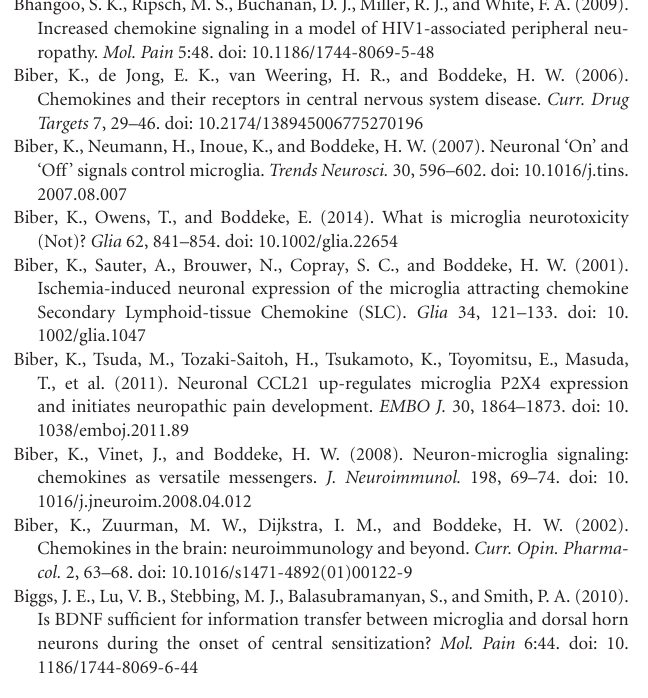
FIGURE 1 | The different roles of CCL2 and CCL21 in the development of neuropathic pain . Both chemokines are induced in DRG neurons in response to nerve injury. CCL2 in the injured DRG may act as local autocrine signal (neuron-neuron signal) and potentially paracrine in the spinal cord where neuronally released CCL2 may stimulate second order neurons in the pain cascade and/or attract CCR2-expressing peripheral monocytes/macrophages. Since there are conflicting data about the transport of CCL2 from the DRG into the spinal cord, alternatively CCL2